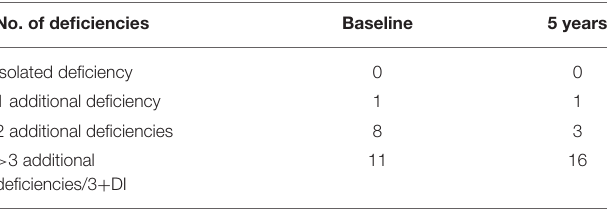
TABLE 1 | Patients’ treatments. Treatment